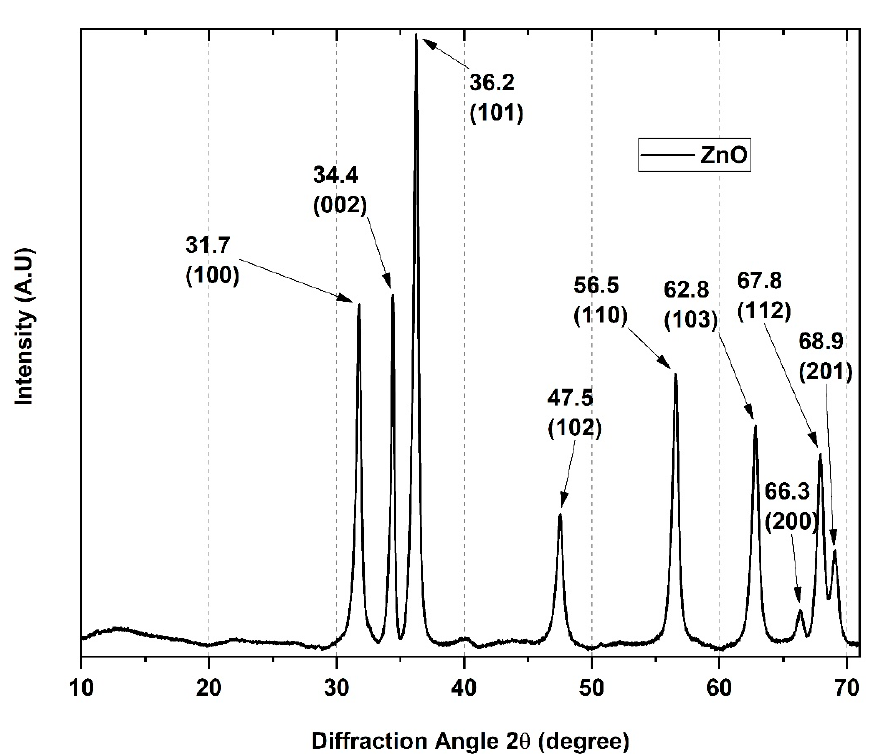
Figure 2. XRD patterns of the ZnO-NPs. The average crystallite sizes ( τ ) for the ZnO-NPs were determined using the Debye- Scherrer Equation (2).